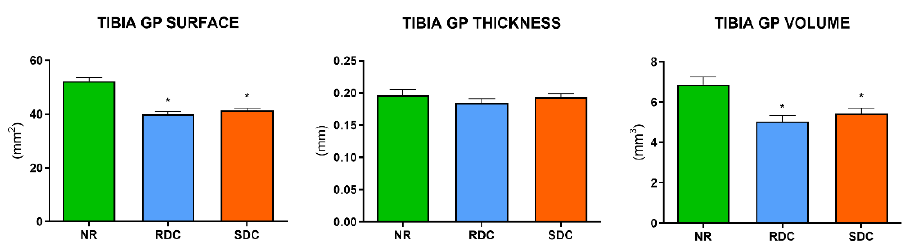
Figure 5. Micro-CT analysis of tibia growth plates at the end of the refeeding period. Values are expressed as mean ± S.E.M. NR group, not restricted group; RDC group, refeeding with rapid digestible carbohydrates diet; SDC group, refeeding with slow digestible carbohydrates diet; GP, growth plate. * Significant difference compared to NR group ( p -value < 0.05).